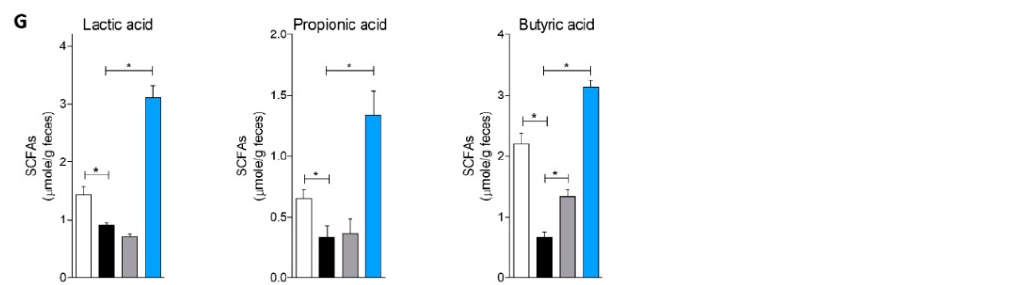
Figure 3. Effects of VSL#3 (Blend 1) and Vivomixx (Blend 2) on clinical course and severity on colitis induced by dextran sulfate sodium (DSS). Balb/c mice administered DSS in drinking water for 8 days alone or in combination with vehicle or one of the two probiotics by gavage from day 0 to day 8. Blend 2 attenuated the development of the disease. Changes in body weight ( A ), area under the curve (AUG) of % of body weight ( B ), and the Colitis Disease Activity Index (CDAI) ( C ) during the course of DSS-induced colitis. Blend 2 reduced the intestinal inflammatory score: colon length ( D ) and ratio of colon weight/colon length ( E ). ( F ) H&E staining of colon sections from control mice, mice treated with DSS, and mice treated with DSS plus probiotics (original magnification 10 × ). ( G ) Concentration of lactic acid (left panel), propionic acid (middle panel), and butyric acid (right panel) determined in the stool of mice collected on day 8. Results are the mean ± SEM of 8–12 mice per group. For panel B, each dot corresponds to a mouse. * p < 0.05. Abbreviations: SCFA, short-chain fatty acid.